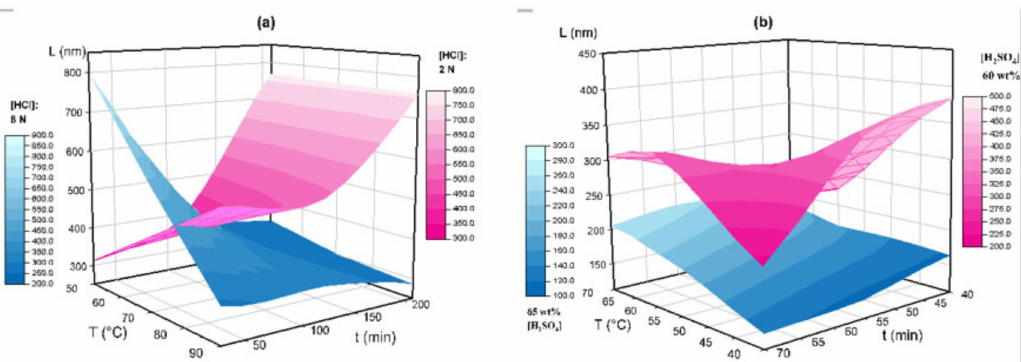
Figure 10. 3D representation of lengths measured by AFM for temperature, time, and different acid conditions: ( a ) HCl hydrolysis, 8N (blue), and 2N (magenta); ( b ) H2SO4 hydrolysis, 65 wt% (blue) and 60 wt% (magenta).